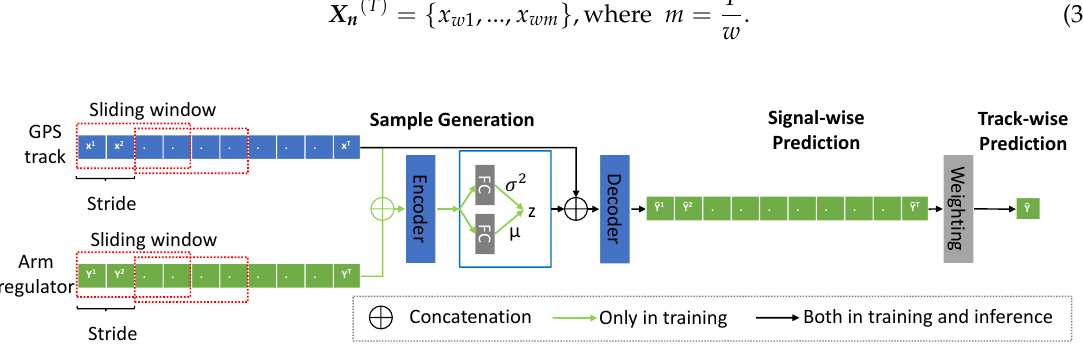
Figure 3. The pipeline of the Conditional Variational Auto-Encoder (CVAE)